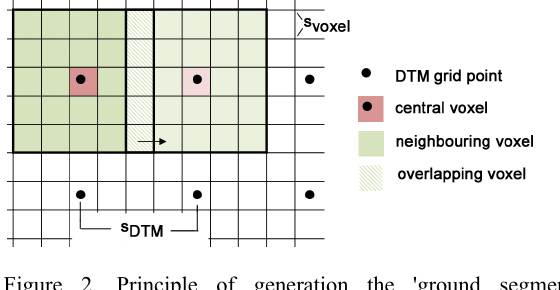
Figure 2. Principle of generation the 'ground segment': horizontal view of voxel space and DTM grid points with moving structure element with second order neighbourhood.